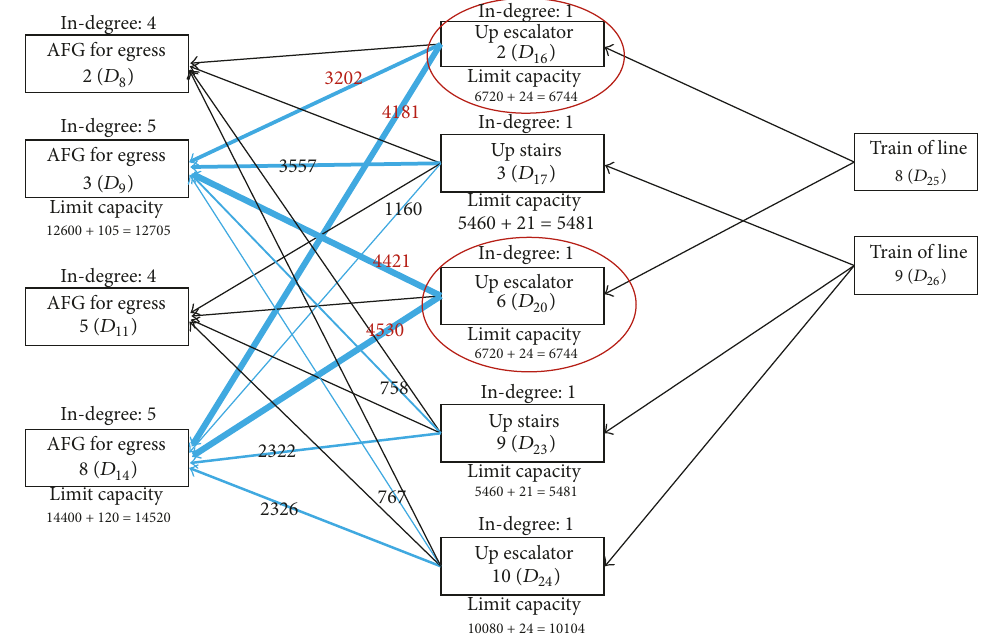
Figure 7: The cascading failure in subnetwork 𝑁 1